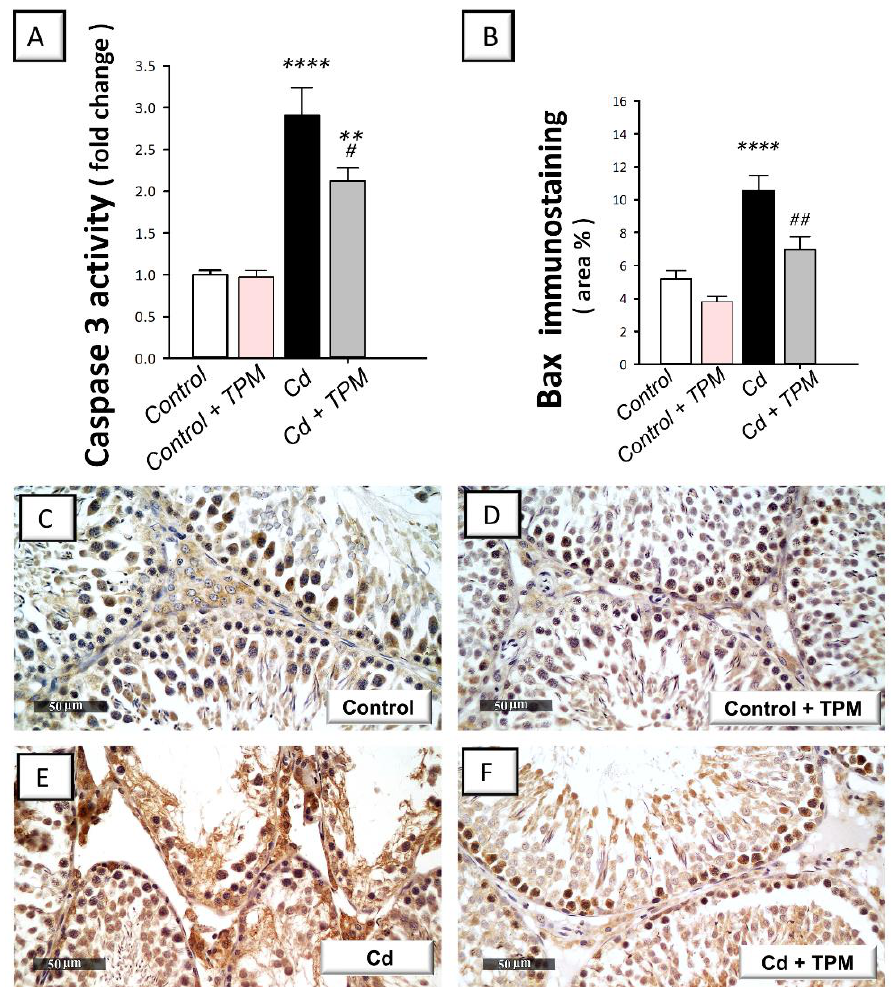
Figure 5. Effect of cadmium and/or topiramate on the pro-apoptotic caspase-3 activity and Bax immunostaining in testes of rats. The co-treatment with topiramate lowered the testicular activity of caspase-3 [H (3, 20) = 23.52, p < 0.0001] ( A ) and the quantification of Bax protein expression [H (3, 20) = 18.54, p < 0.0001] ( B ) that were increased by cadmium administration. The determination of Bax protein expression was carried out by the detection of its immunostaining (brown color) in the testes of animals at 400 × magnification. The slides were counterstained with hematoxylin. ( B ) Quantitative analysis of Bax immunostaining. The quantification was presented as the area % of the brown immunostaining relative to the microscopic field’s whole area (in each section, six non-overlapping fields were investigated). Results are demonstrated as the mean ± standard error of the mean (SEM). ** p < 0.01, **** p < 0.0001 signifies statistical significance versus the control group; # p < 0.05, ## p < 0.01 signifies statistical significance versus cadmium chloride-treated group. ( C , D ) Representative photomicrographs showing minimal expression in the control and topiramate-treated control groups, respectively. ( E ) Representative photomicrographs showing increased immunostaining of Bax in cadmium-intoxicated group. ( F ) Representative photomicrographs showing that topiramate downregulated the protein expression of Bax as indicated by lowered immunostaining. Bax. Bcl-2-associated x- protein. TPM, topiramate; Cd, cadmium chloride.